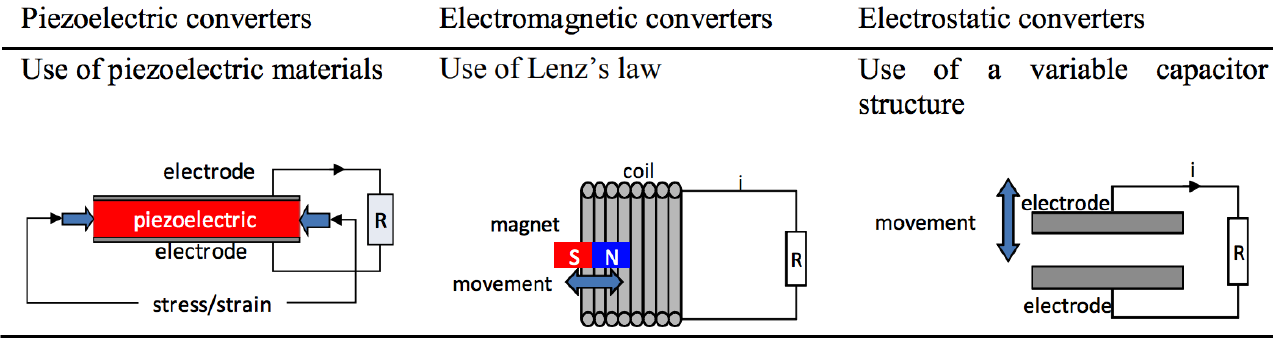
Figure 20. Different principles to convert mechanical energy into electricity